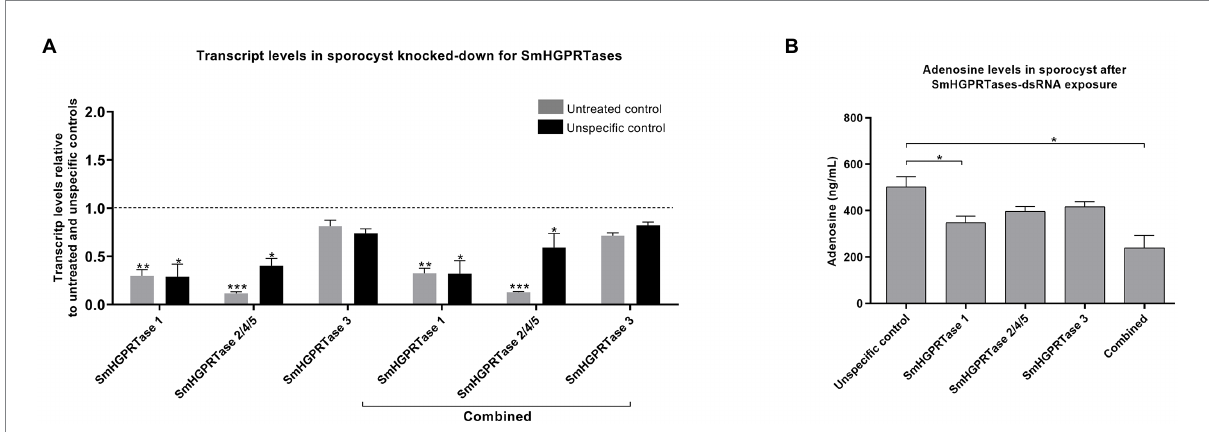
FIGURE 5 SmHGPRTases transcript levels after sporocysts exposure to dsRNAs and knockdown effects in adenosine levels. (A) Bars representing the transcript levels of SmHGPRTase 1, SmHGPRTase 2/4/5, and SmHGPRTase 3 in sporocysts after exposure to the specific dsRNAs separately or in combination (combined) relative to the untreated (gray) or unspecific control (black) after 4 days. Above the bars are represented the standard error of the mean of three replicates. The dashed line represents the normalized values in the controls. (B) Bars representing the adenosine levels in sporocysts in the respective groups: unspecific control, parasites treated with SmHGPRTase 1 -dsRNA, SmHGPRTase 2/4/5 -dsRNA, SmHGPRTase 3 -dsRNA, and the combined group. Above the bars are represented the standard error of the mean of three replicates. After verifying the normality using the Shapiro–Wilk test, significant differences compared to control conditions were analyzed by unpaired t -test (* p ≤ 0.05; ** p ≤ 0.01; *** p ≤